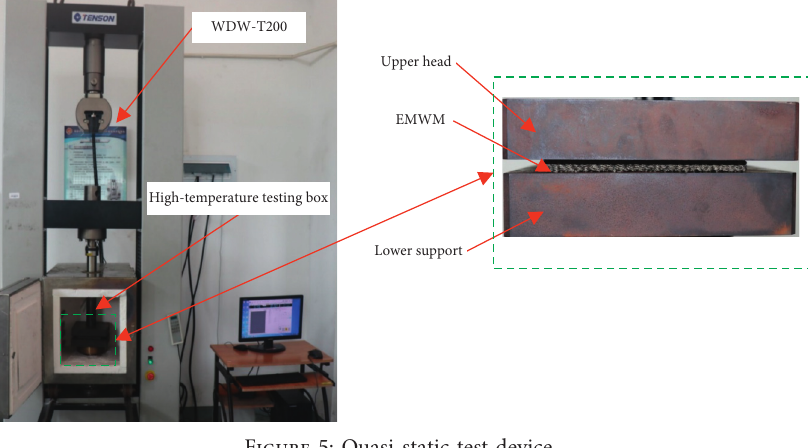
Figure 5: Quasi-static test